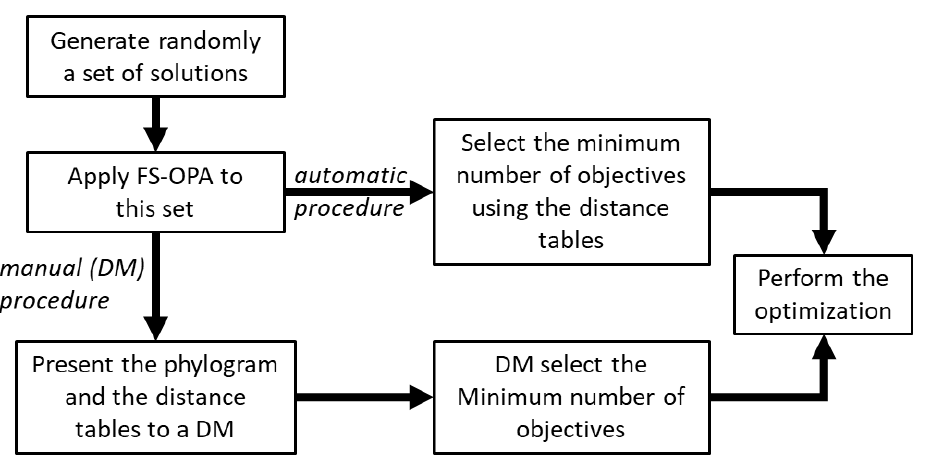
Figure 4. The general procedure of FS-OPA for the reduction of the number of